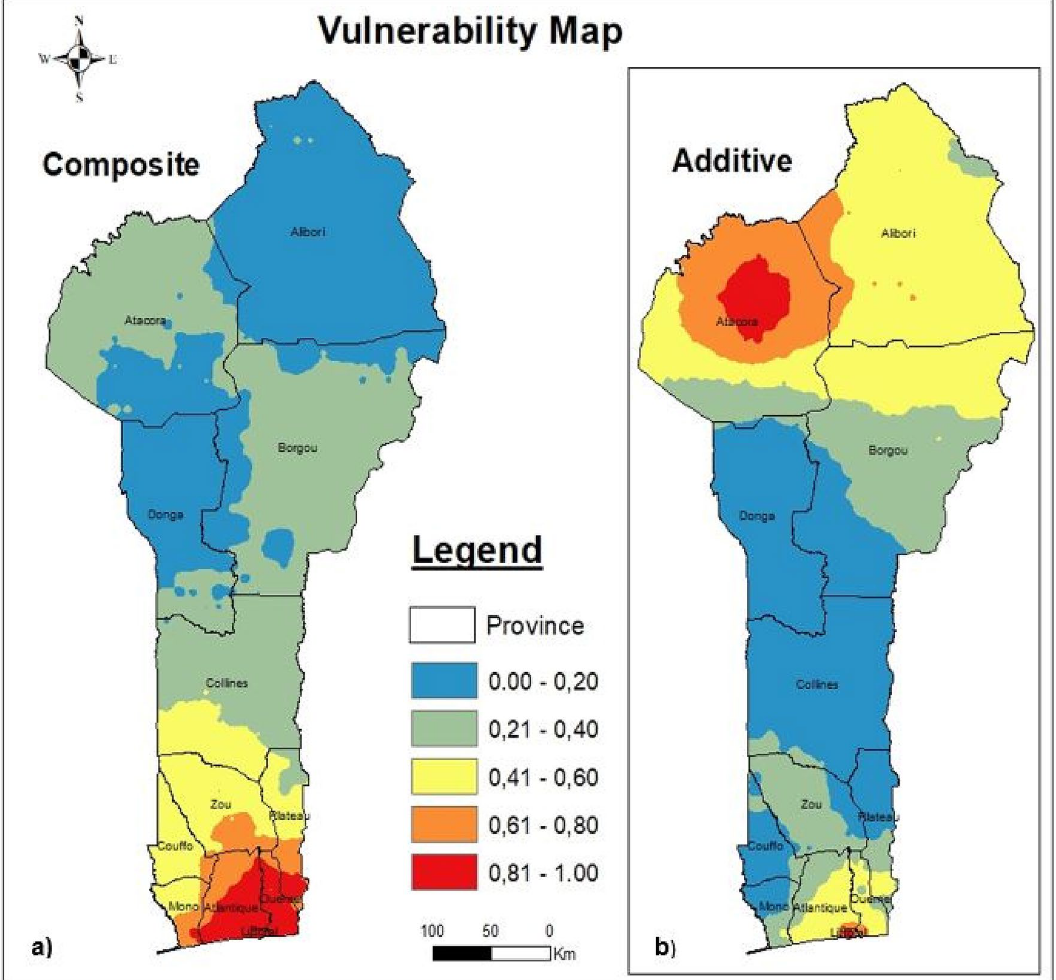
Figure 5. Observed composite and additive EVI map.